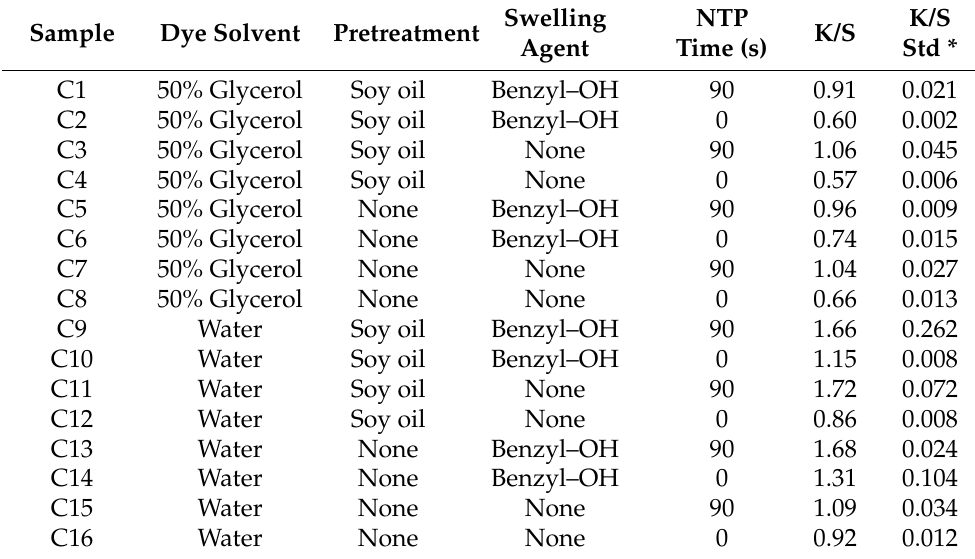
Table 3. Experiment C: experimental design and the results @ .